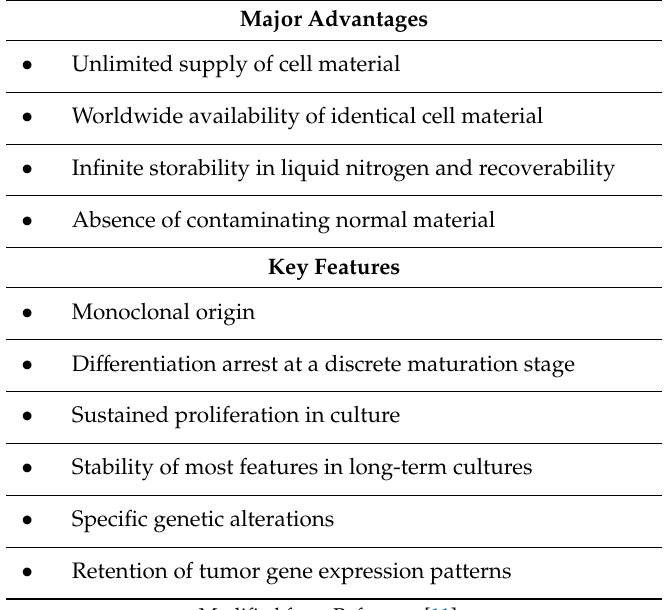
Table 1. Advantages and Key Features of Leukemia–Lymphoma Cell